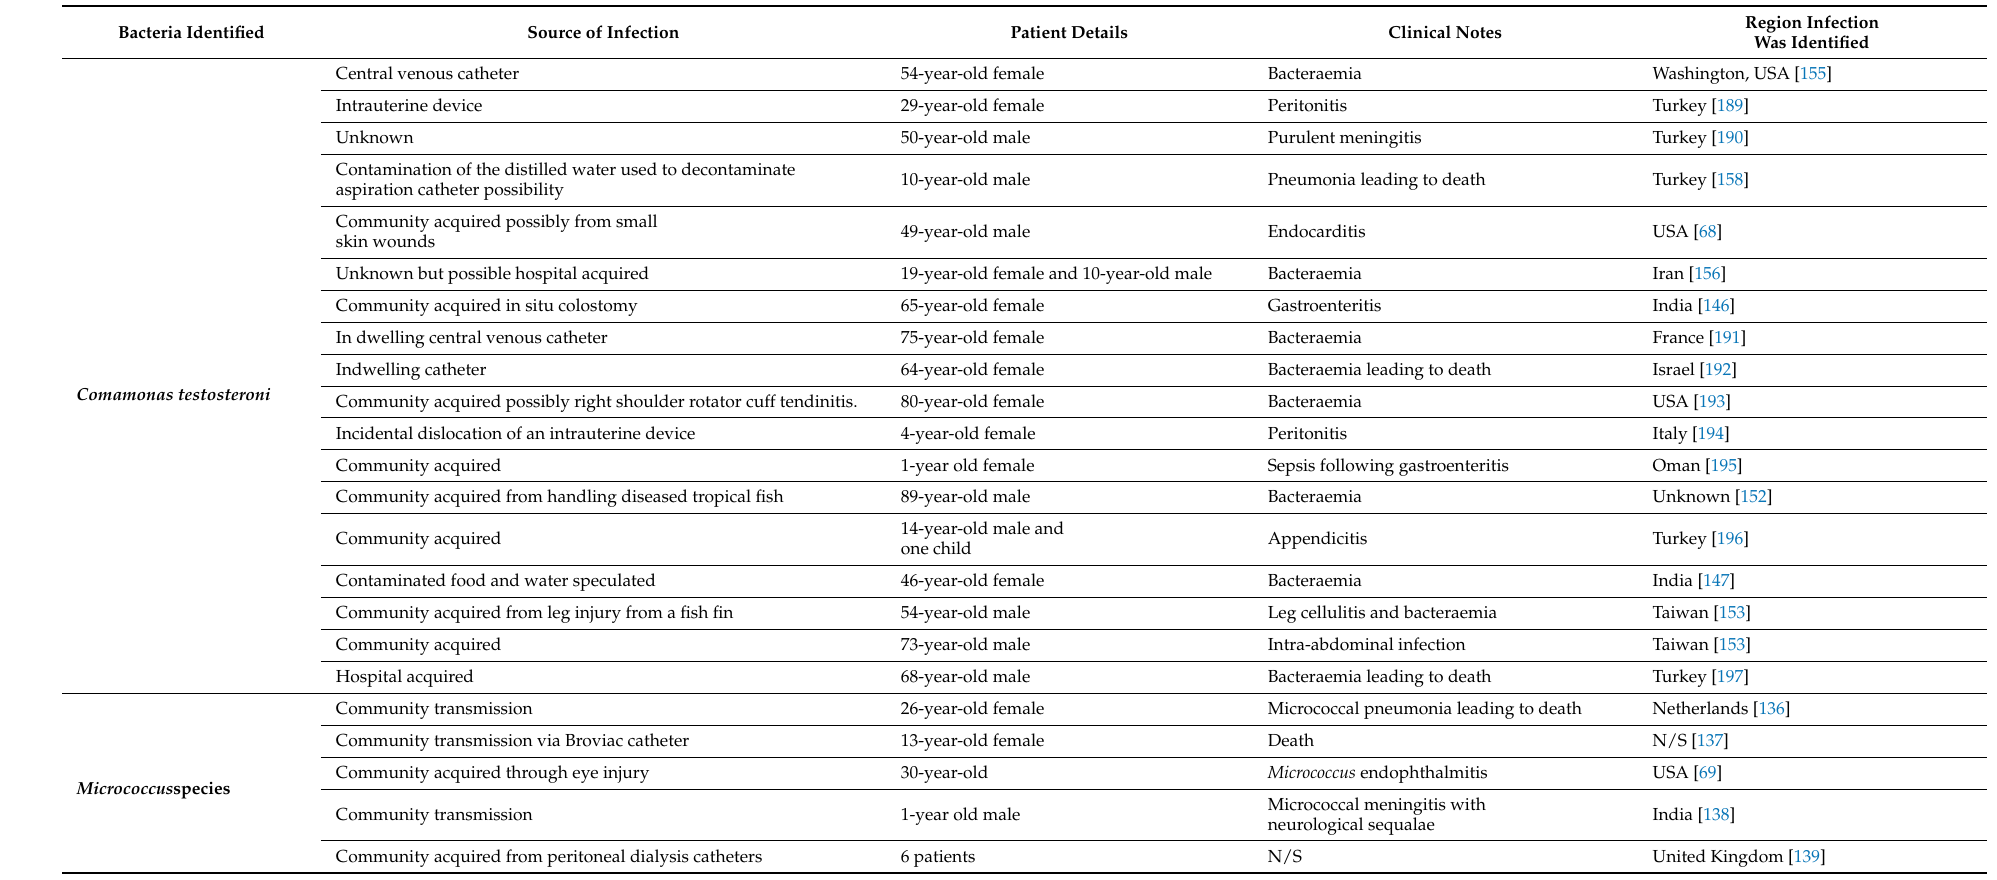
Table 7. Cases of human infection associated with zoonotic bacteria identified in this manuscript . N/S indicates not stated in cited publication. Bacteria